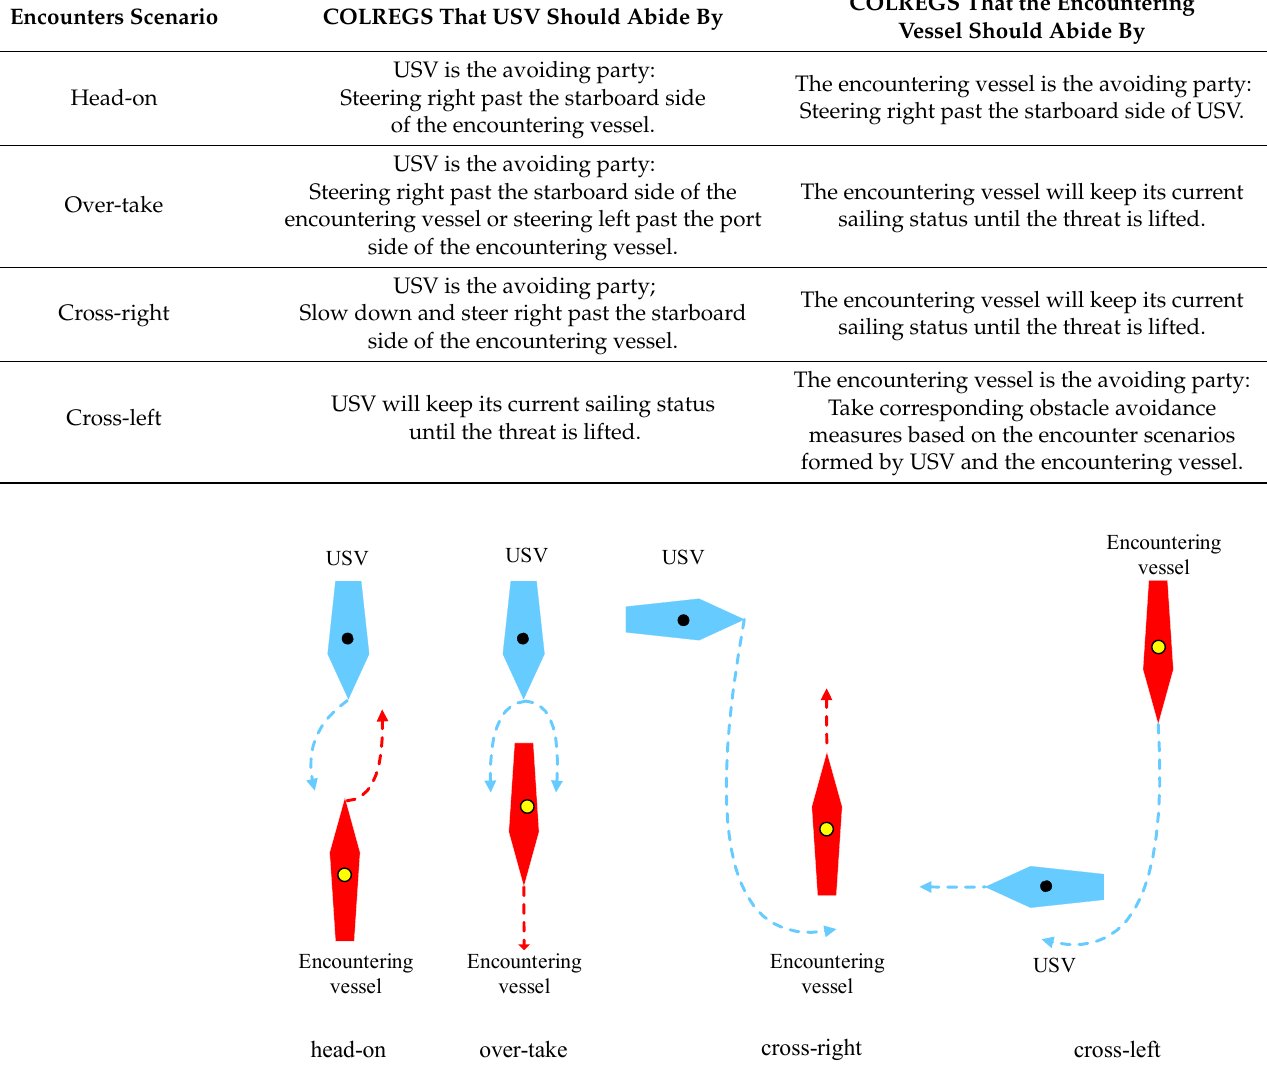
Figure 6. Obstacle avoidance model under COLREGS.